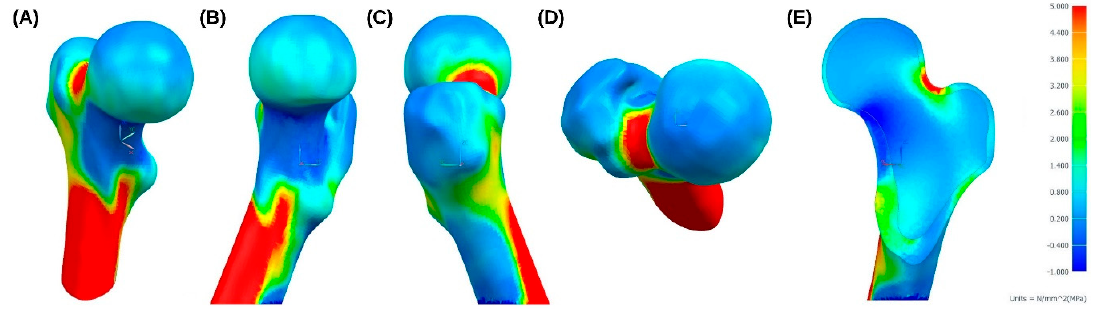
Figure 10. ( A ) Isometric, ( B ) right, ( C ) left, ( D ) top and ( E ) back view of maximum principal stress field in proximal femur when applying jogging loads.